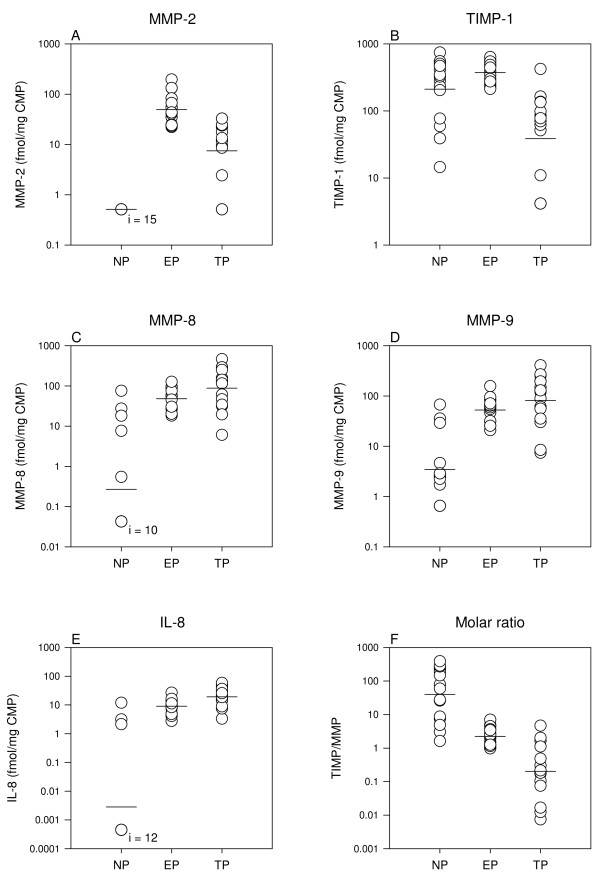
Gestational age. One-way analysis of variance showed different mean values in each of the panels A-F (P < 0.001). The P-values of the post-hoc pairwise comparison are listed in the results section. NP: non-pregnant (n = 15), EP: early pregnant (n = 15), TP: term pregnant (n = 15), i: subset of n. Note the log-scale.